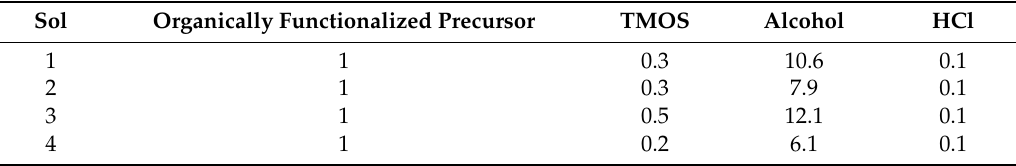
Table 2. Molar ratios of reagents for obtained